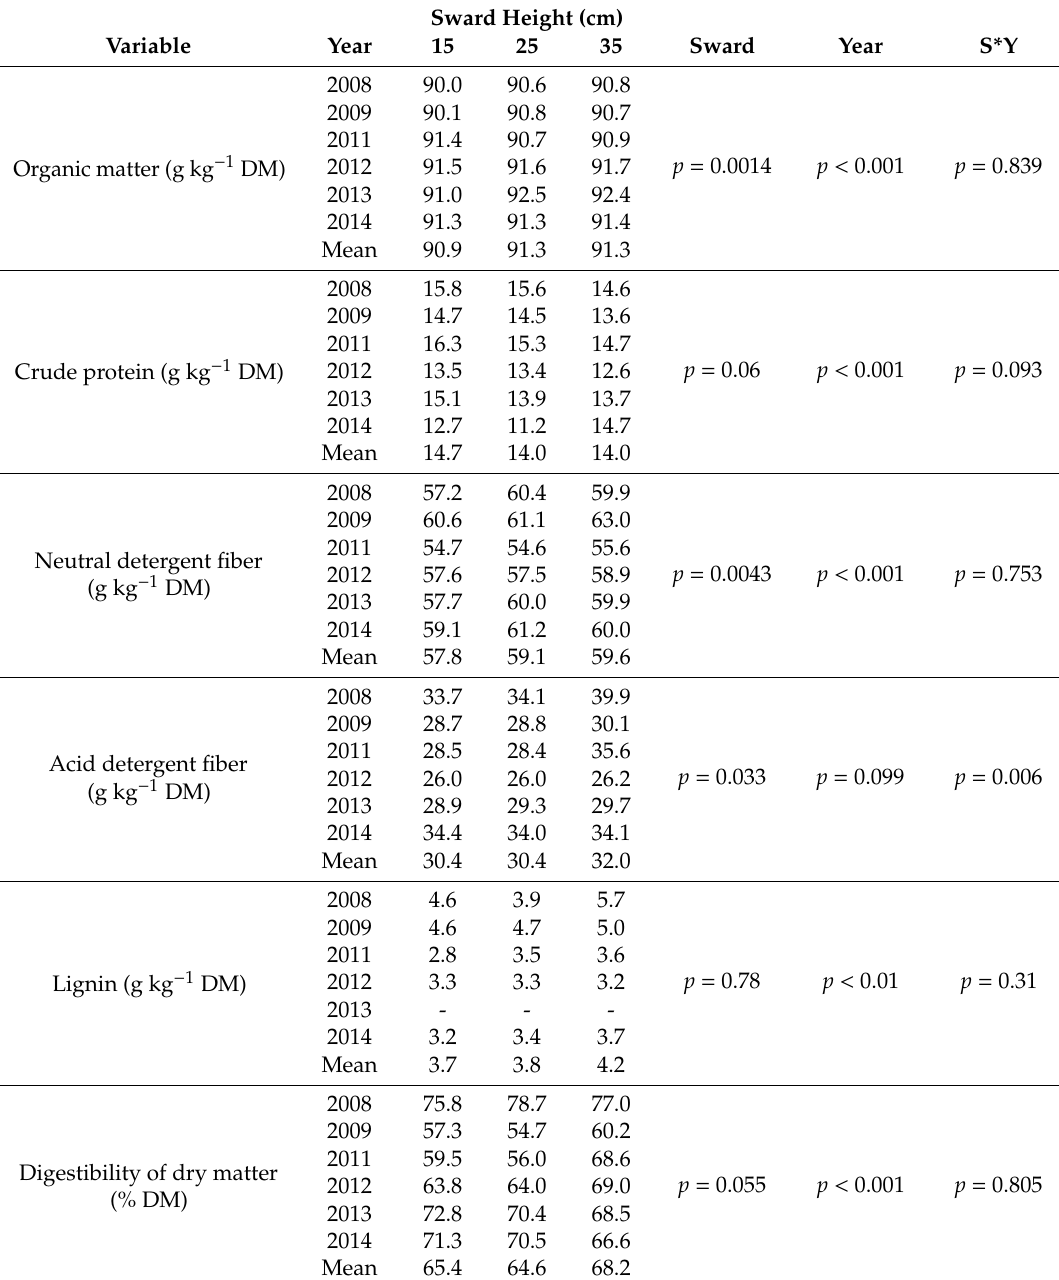
Table 4. Nutritive values for Marandu grass (hand plugged sample) managed at different sward heights 1